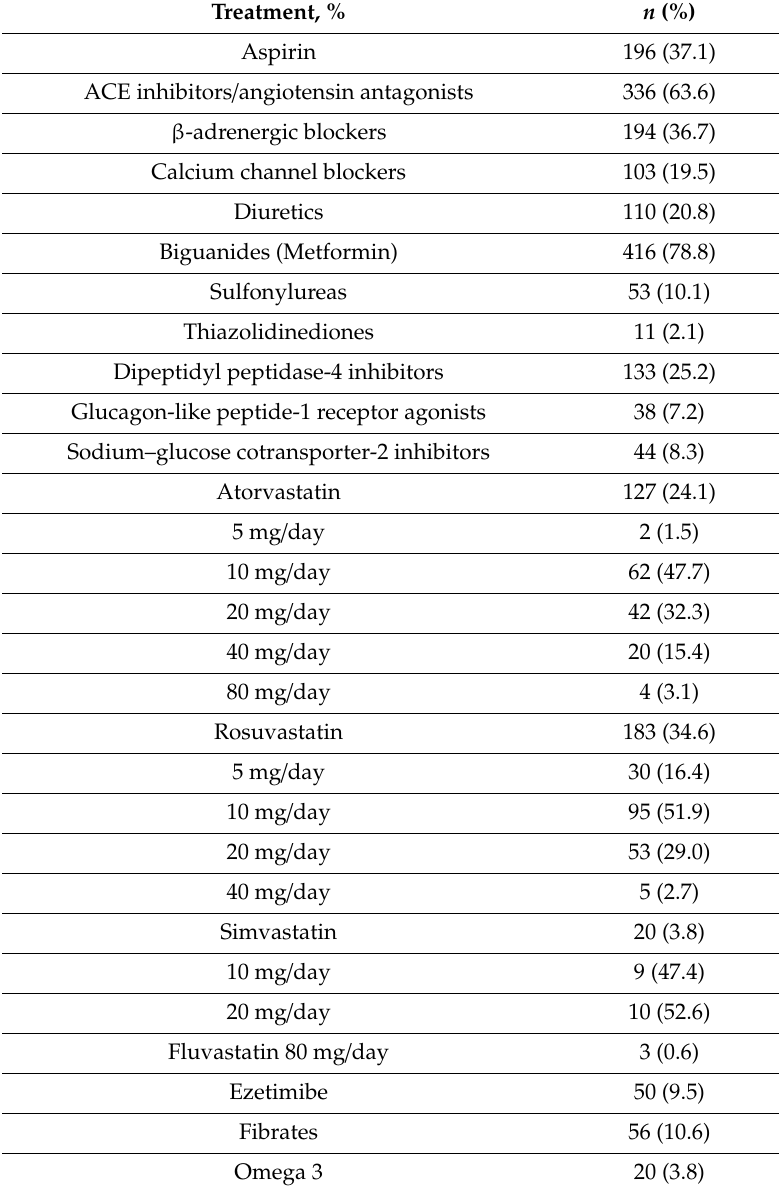
Table 2. Pharmacological treatment of the population ( n =